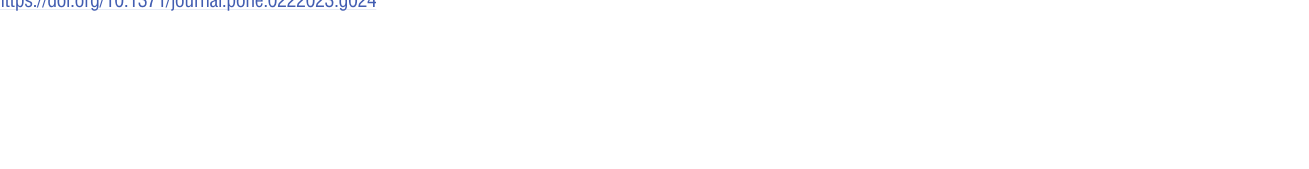
PLOS ONE | https://doi.org/10.1371/journal.pone.0222023 September 11,